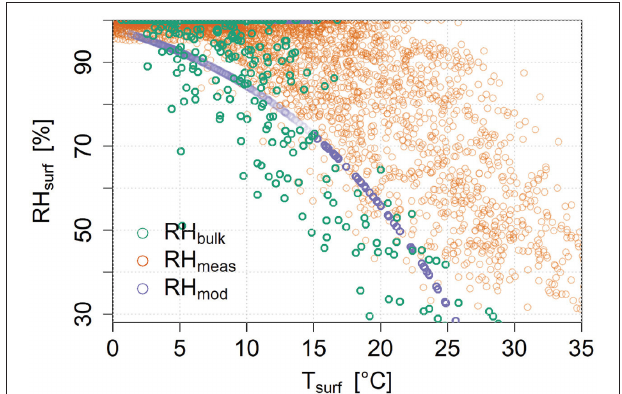
FIGURE 12 | Relative humidity at the surface, necessary to fit the bulk model to eddy correlation measurements (RH bulk ), measured embedded in the debris surface during a subsequent measurement campaign at the same location (RH meas ) and obtained using a regression based on (Haghighi and Or, 2015a) (RH mod ).